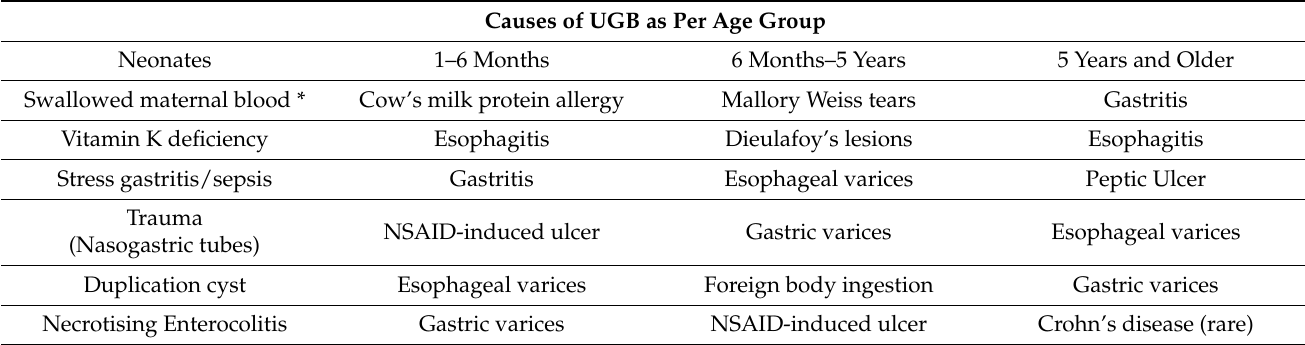
Table 1. The medical causes of UGB as per age group. Causes of UGB as Per Age